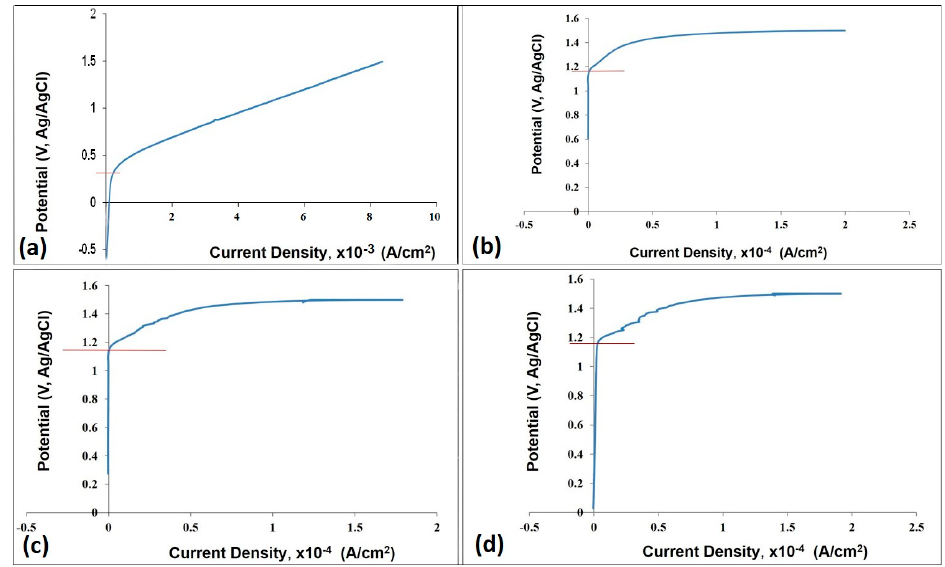
Figure 8. AP Measurements for ( a ) Al substrate, ( b ) HA, ( c ) PEO and ( d ) PSC coatings. Processes 2018 , 6 , x FOR PEER REVIEW